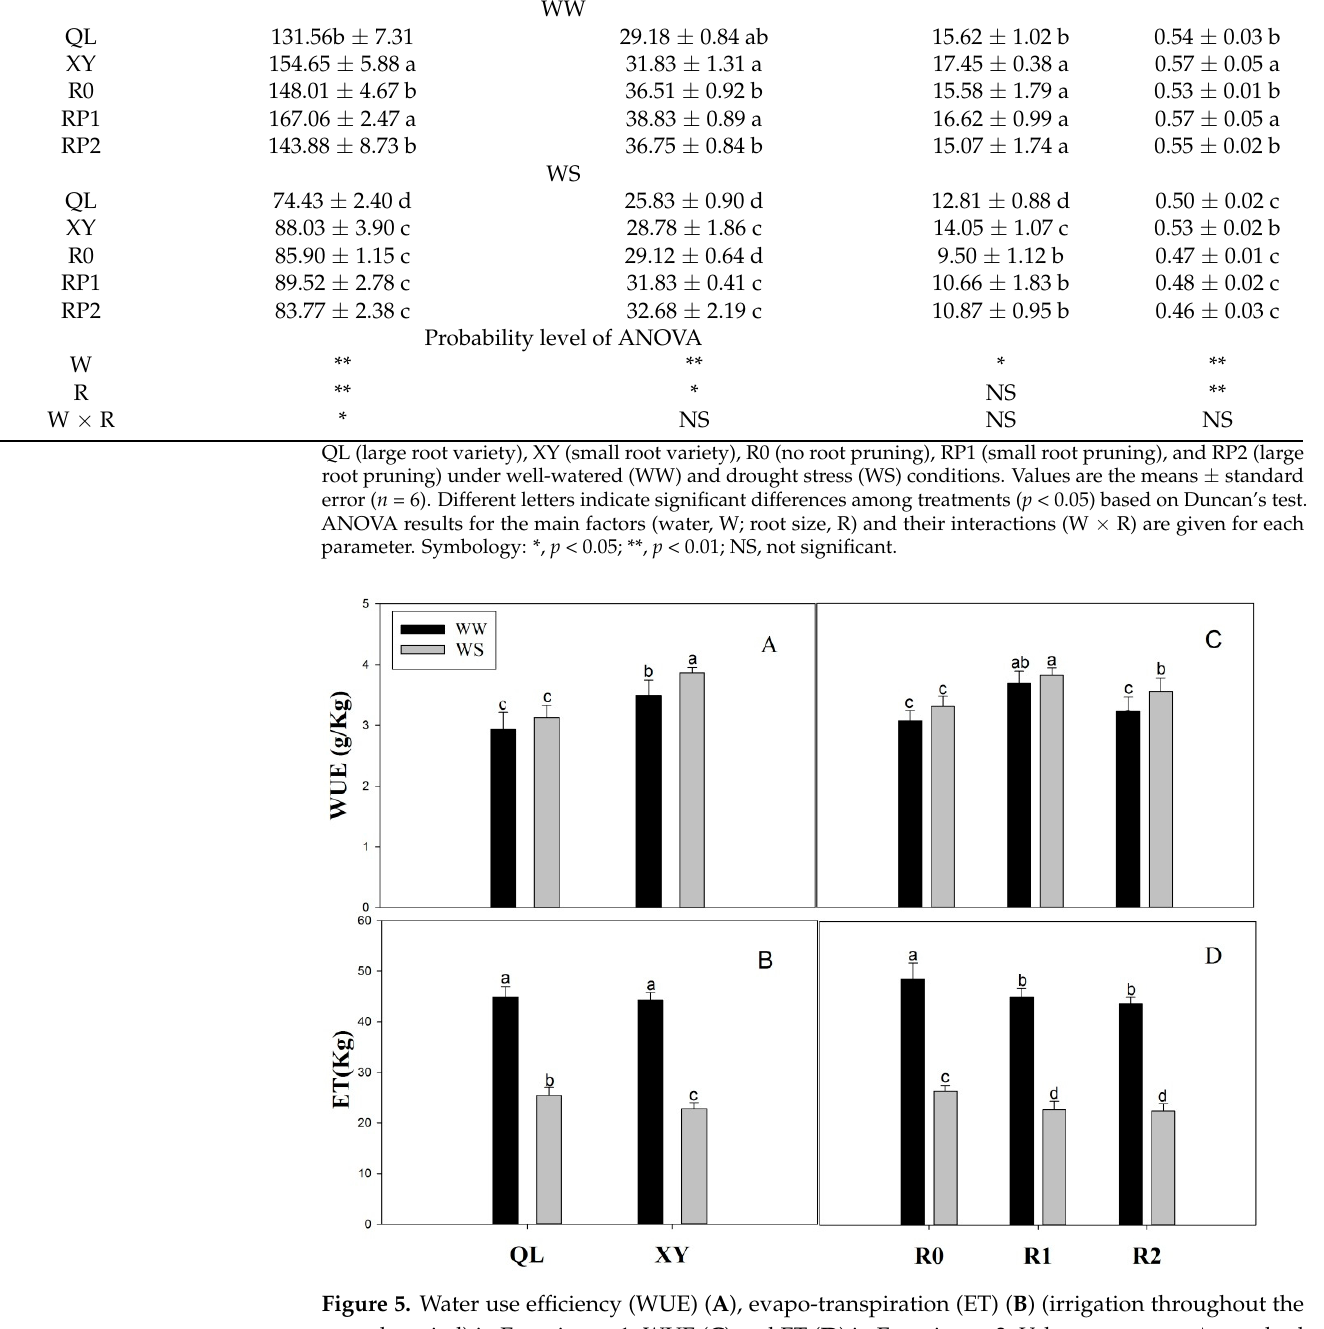
Table 3. Correlations among yield, yield components, and physiological indices under well-watered (WW) and drought stress (WS) conditions.